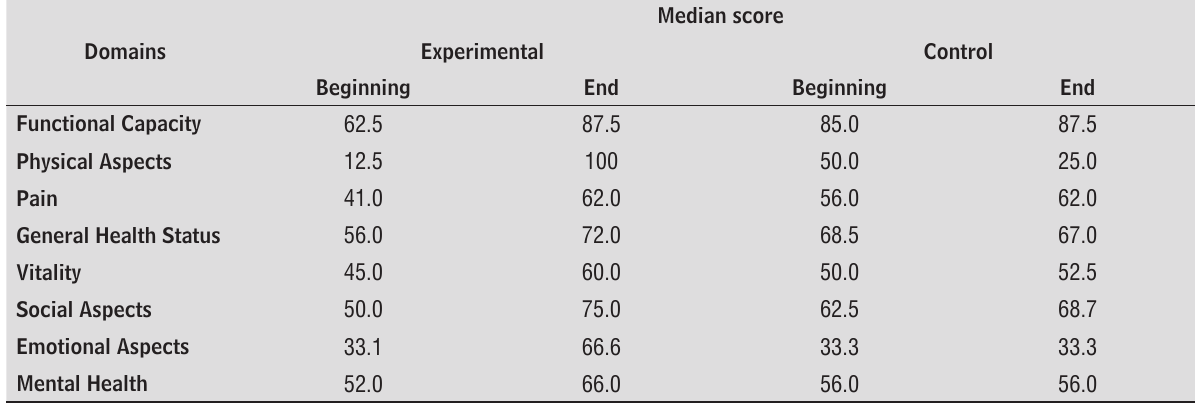
Table 3 - Median scores of the SF-36 in each domain in both groups, Ribeirão Preto-SP, 2008